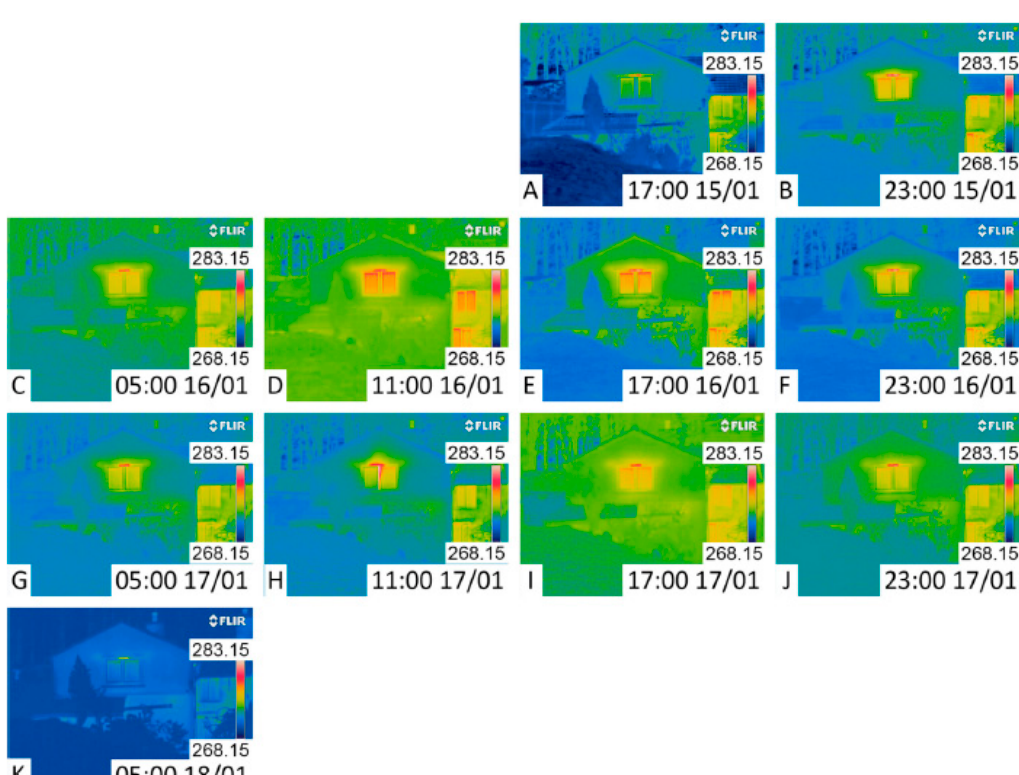
Figure 16. Thermographic images of a building envelope taken every 6 h [86].